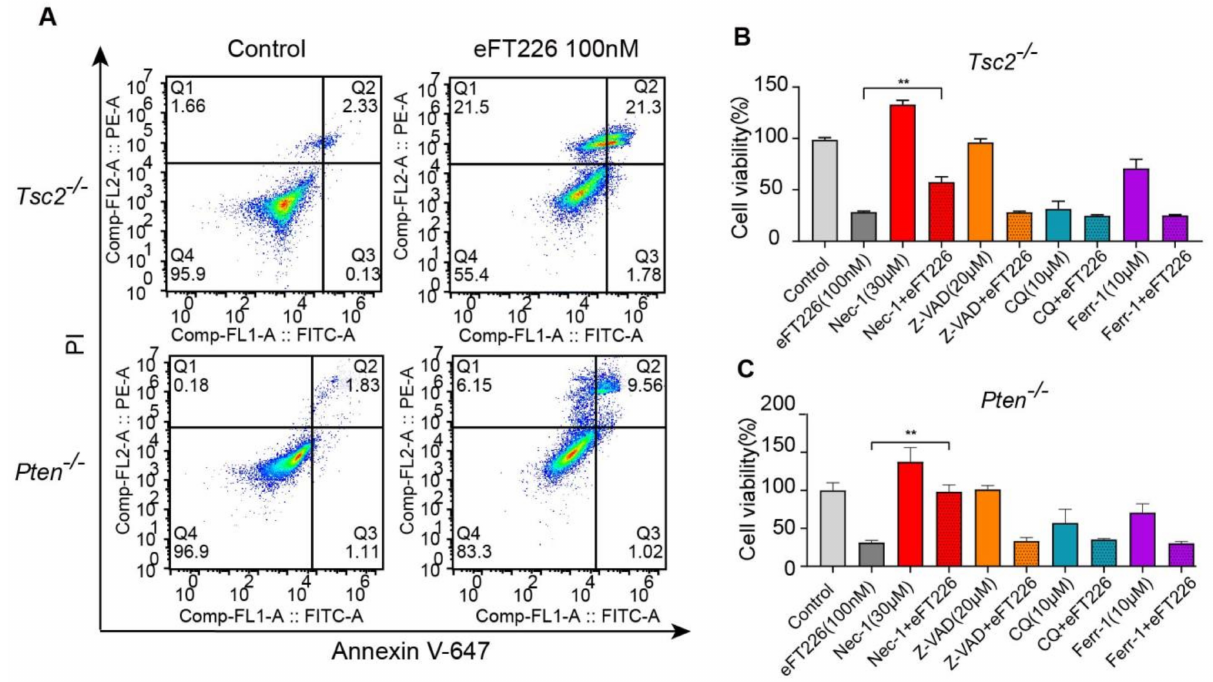
Figure 3. eFT226 triggers necroptosis of Tsc2 - and Pten -deficient cells. ( A ) Tsc2 - and Pten -deficient MEFs were treated with eFT226 (100 nM) or its solvent DMSO in triplicate for 48 h. Cells were stained with Annexin V-647 and propidium iodide (PI) for dead cells then analyzed with Accuri C6 flow cytometer. Tsc2 - ( B ) and Pten -deficient MEFs ( C ) were treated with or without eFT226 (100 nM) and/or various inhibiters in quintuplicate for 48h. Cell viability was checked by CCK-8 assay. Values are mean ± S.D. of 3 independent experiments in comparison with the control. ** p <